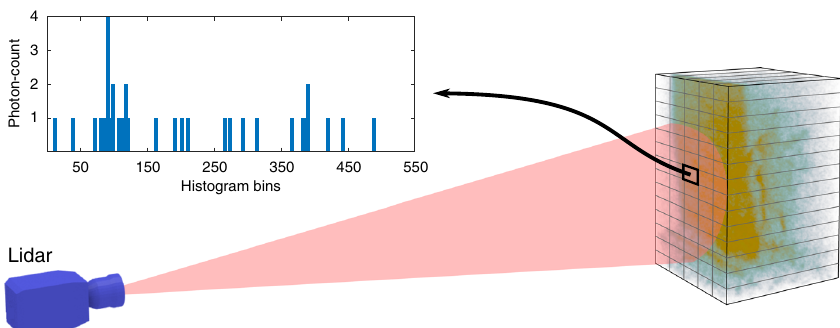
Fig. 1 Illustration of a single-photon lidar dataset. The dataset consists of a man behind a camou fl age net 15 . The graph on the left shows the histogram of a given pixel with two surfaces. The limited number of collected photons and the high background level makes the reconstruction task very challenging. In this case, processing the pixels independently yields poor results, but they can be improved by considering a priori knowledge about the scene ’